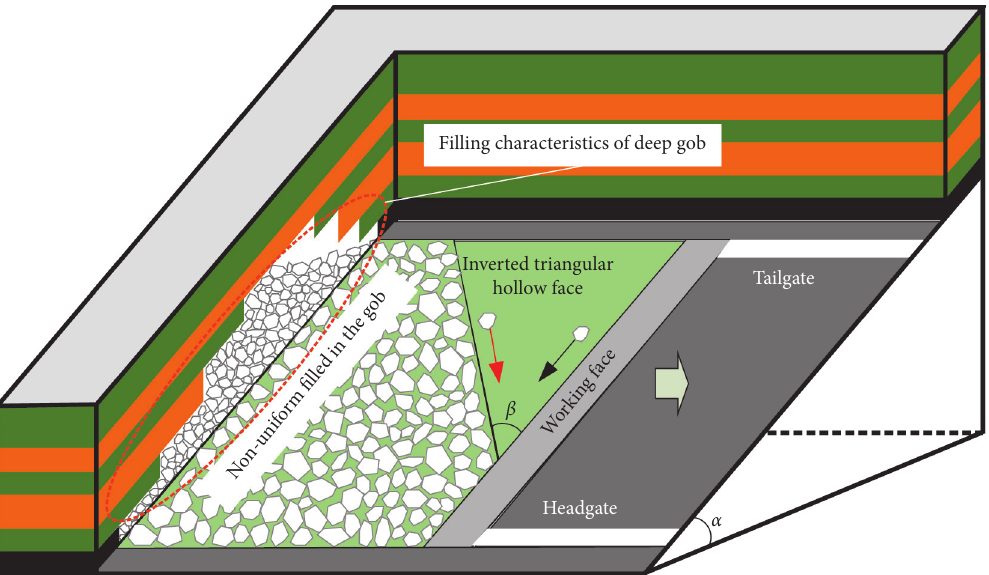
Figure 4: Filling characteristics of the gob.